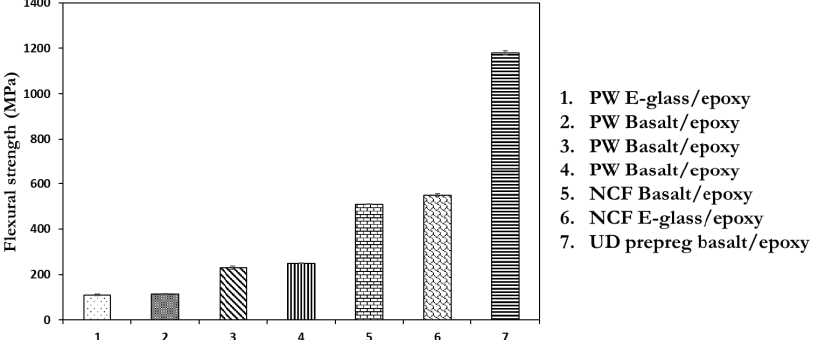
Figure 10. A comparison between flexural strength following moisture ageing of Basalt/epoxy com- posites against composites manufactured using E-glass fibre as reinforcement [1,2 – Wei et al [142],